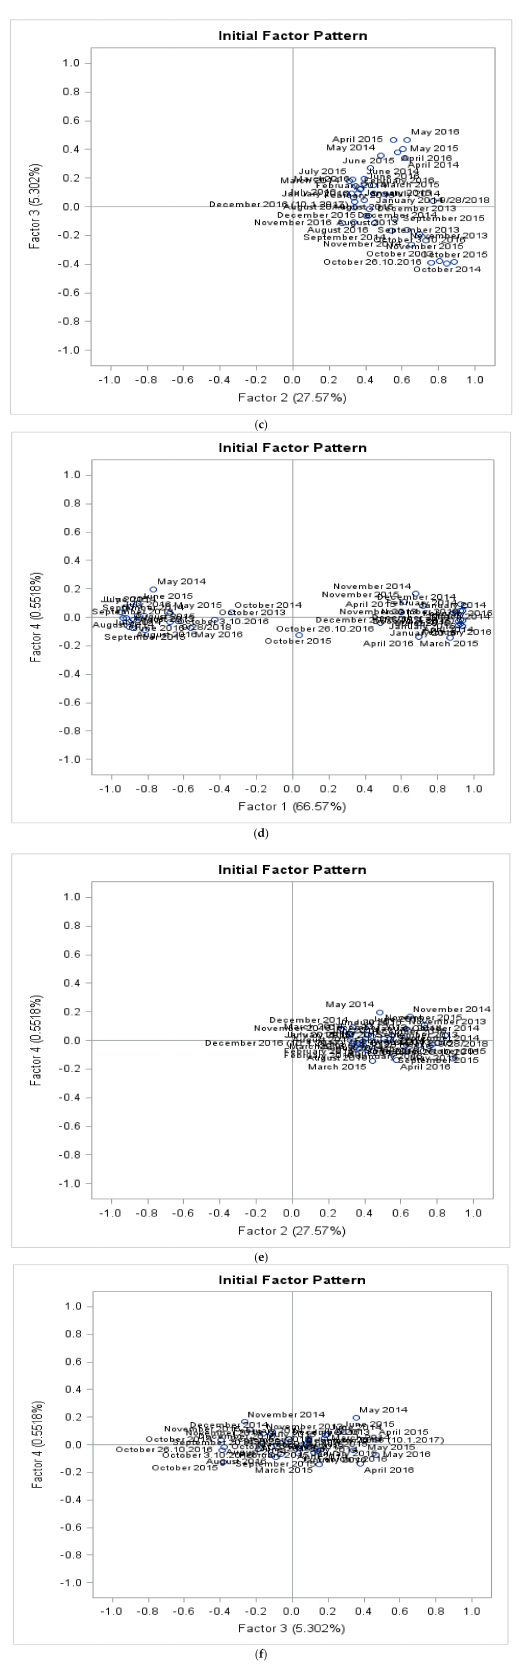
Figure 15. Six score plots built for four factor combinations at the Ketunkatu site. ( a ) Factor 2 vs. Factor 1. ( b ) Factor 3 vs. Factor 1. ( c ) Factor 3 vs. Factor 2. ( d ) Factor 4 vs. Factor 1. ( e ) Factor 4 vs. Factor 2. ( f ) Factor 4 vs. Factor